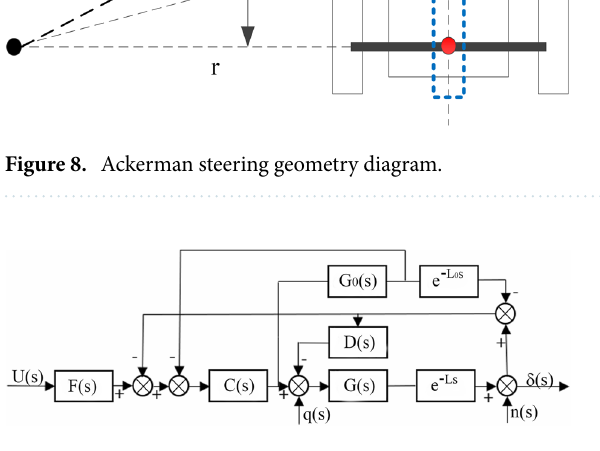
Figure 9. Structural block diagram of hydraulic steering